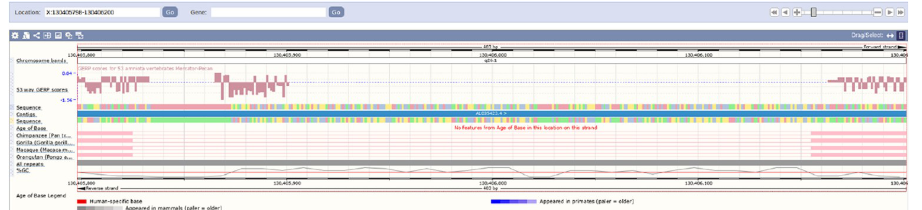
Fig 9. Cross-species evolutionary comparison of Alu deletion within intron 3 of the RBMX2 gene (ChrX:130,405,798–130,406,200). On the top, the human sequence is compared to the following primates: chimpanzee, gorilla, macaque and orangutan. The target site duplications (TDSs: TGCTTTGCC ) are indicated with black arrows flanking the Alu element and the polypyrimidine track is marked with a dashed black line.